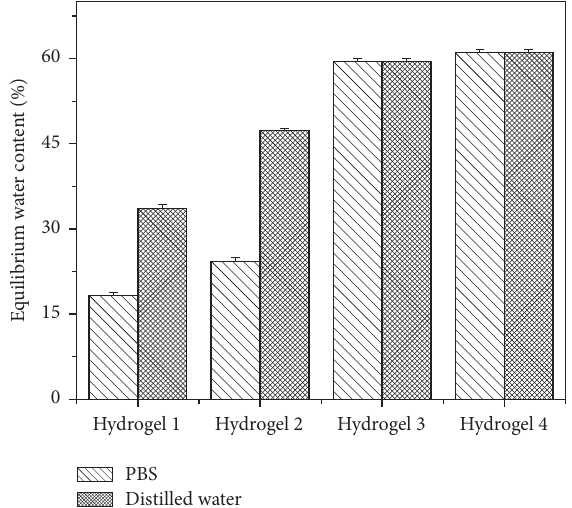
Figure 2: The equilibrium water content of